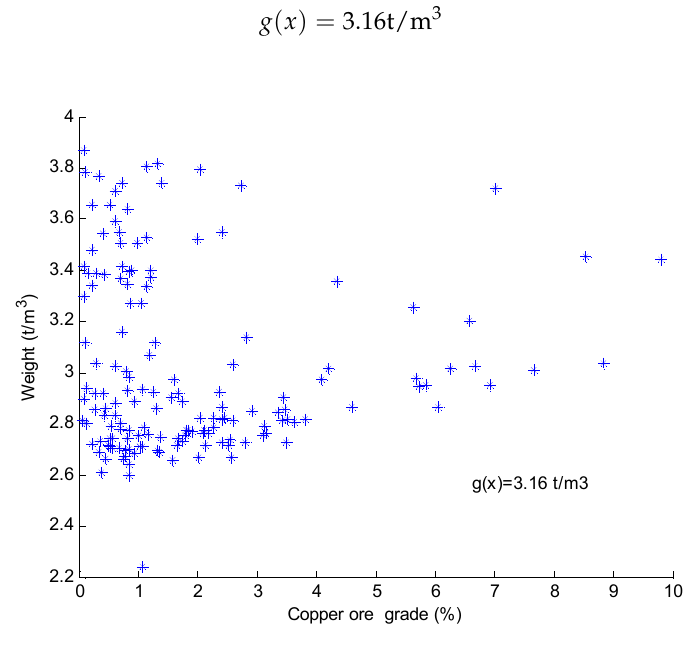
Figure 6. Scatter plot of ore weight and grade.